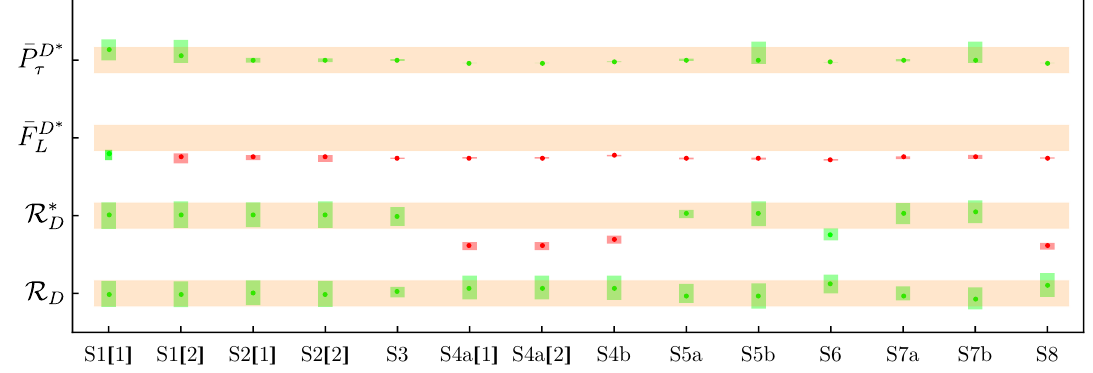
Figure 9 . Predictions for the (cid:12)tted observables, normalized to their measured values, with their 1 (cid:27) experimental uncertainties shown as orange bands. For these predictions B ( B c ! (cid:28) (cid:22) (cid:23) ) (cid:20) 10% is taken. The green and red regions indicate the predictions arising from each NP scenario that are in agreement or not with the experimental value, respectively, at the 1 (cid:27) level. The labels within brackets specify the minimum within a given scenario. The numerical values of these predictions are listed in table